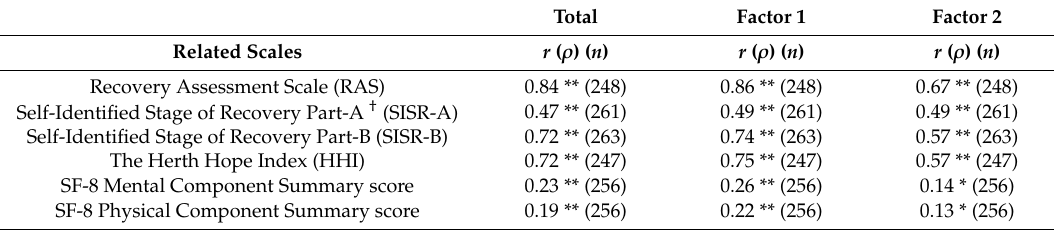
Table 3. Pearson’s (Spearman’s) correlation coe ffi cients of the total benefit finding questionnaire (BFQ) score and scores of each factor with related scales ( N =